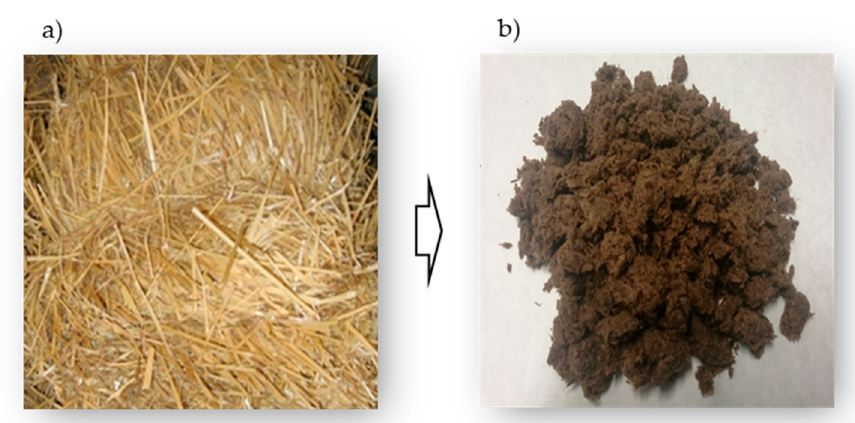
Figure 1. Barley straw images ( a ) before being treated and ( b ) after the thermomechanical